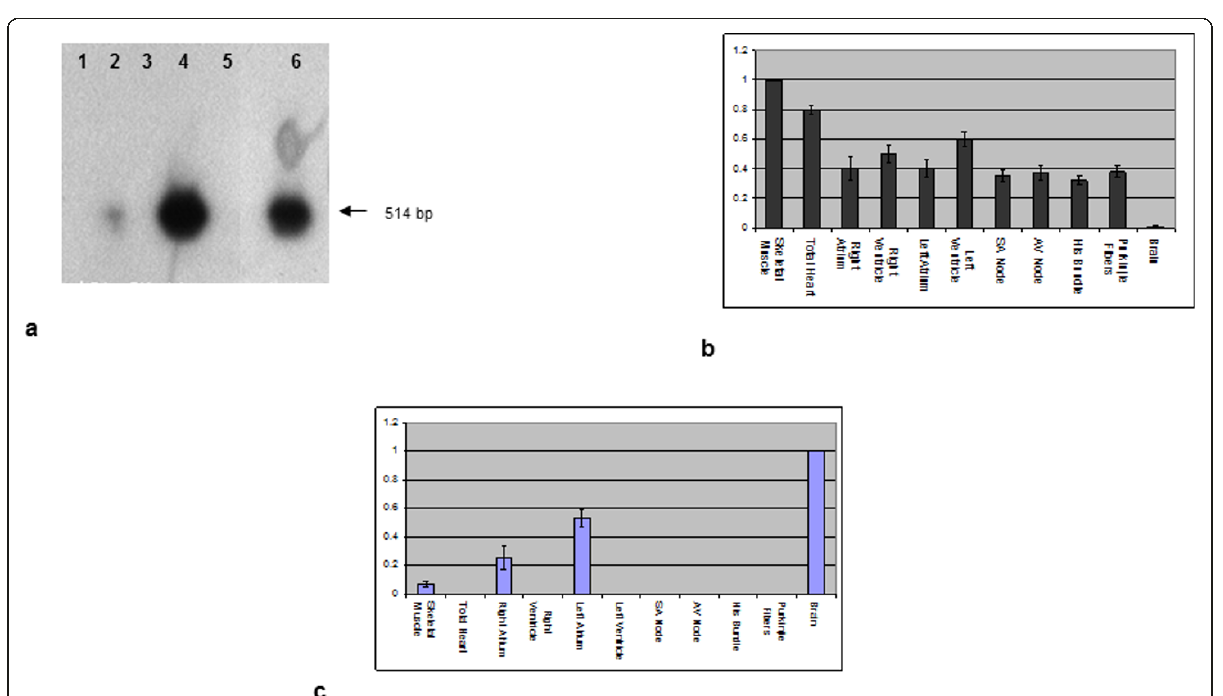
Figure 1 a. Hybridization of dystrophin B isoform RT-PCR (oligonucleotides within B exons 1 and 6; expected product: 514 bp) with an internal oligo probe (within exon 2) that confirmed its expression in both Atria (lanes 2 and 4) and in the control brain (lane 6), and its absence in the Ventricles and Total Heart . b Levels of dystrophin M transcript expression (2- ΔΔ CT values) using the skeletal muscle as internal calibrator and actin as reference gene in: Skeletal Muscle, Total heart, Right Atrium, Right Ventricle, Left Atrium, Left Ventricle, Sinoatrial (SA) Node, Atrioventricular (AV) Node, Bundle of His and Purkinje Fibres. The M isoform was expressed in all the samples studied, featuring the lowest score in Brain. c Levels of dystrophin B transcript expression (2- ΔΔ CT values) using the brain as internal calibrator and actin as reference gene in the same samples. In both the ventricles the B amplification threshold cycle (CT) was undetermined, as well as in the total heart and in the conduction system structures. In the atria the score obtained was higher than that in skeletal muscle, in particular in the left